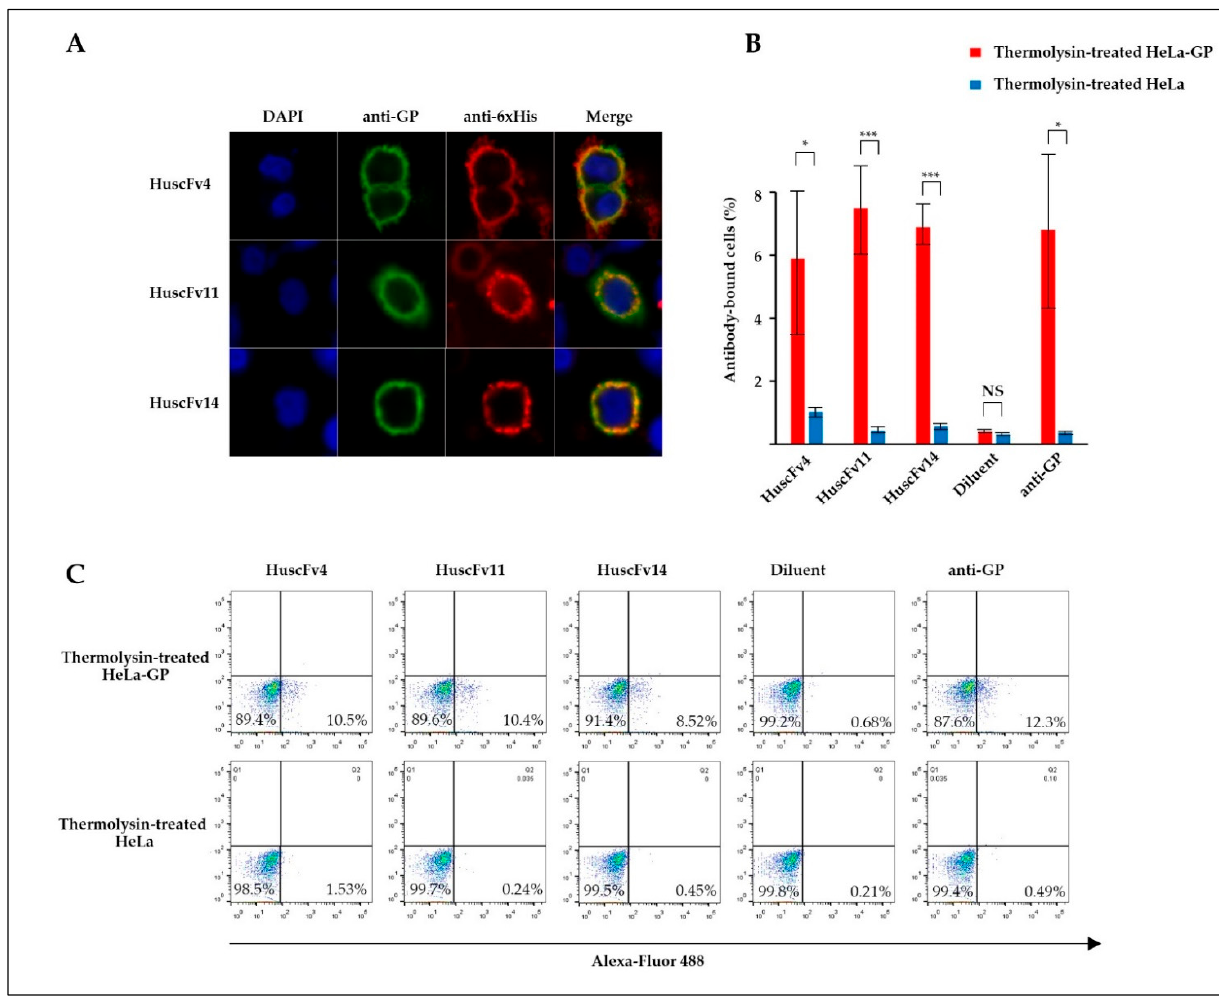
Figure 4. Binding of HuscFvs to GPcl. ( A ) GP-expressed HeLa cells (HeLa-GP) were treated with thermolysin at 37 °C for 1 h. Cells were washed and seeded on cover slips in the presence of 30 µg/mL of indicated HuscFvs at 37 °C for 2 h, followed by staining with primary (anti-6 × His and anti-GP antibodies) and fluorophore-conjugated secondary antibodies. Co-localization of GPcl (green) and HuscFvs (red) was visualized by confocal microscopy (orange/yellow in Merge). ( B ) Percent HuscFv-binding to HeLa-GP or HeLa cells. HeLa-GP or HeLa cells were treated with thermolysin, as described in ( A ), and incubated with 1 µg/mL of indicated HuscFvs or diluent on ice for 1 h, followed by staining with primary anti-6 × His or anti-GP antibodies and Alexa-Fluor 488-conjugated secondary antibodies. Stained cells were analyzed by flow cytometry. Results are shown as mean ± standard error of three independent experiments. ( C ) The result and gating strategy of one representative experiment in ( B ) are shown. *, p < 0.05; ***, p < 0.001; NS, not significantly different.